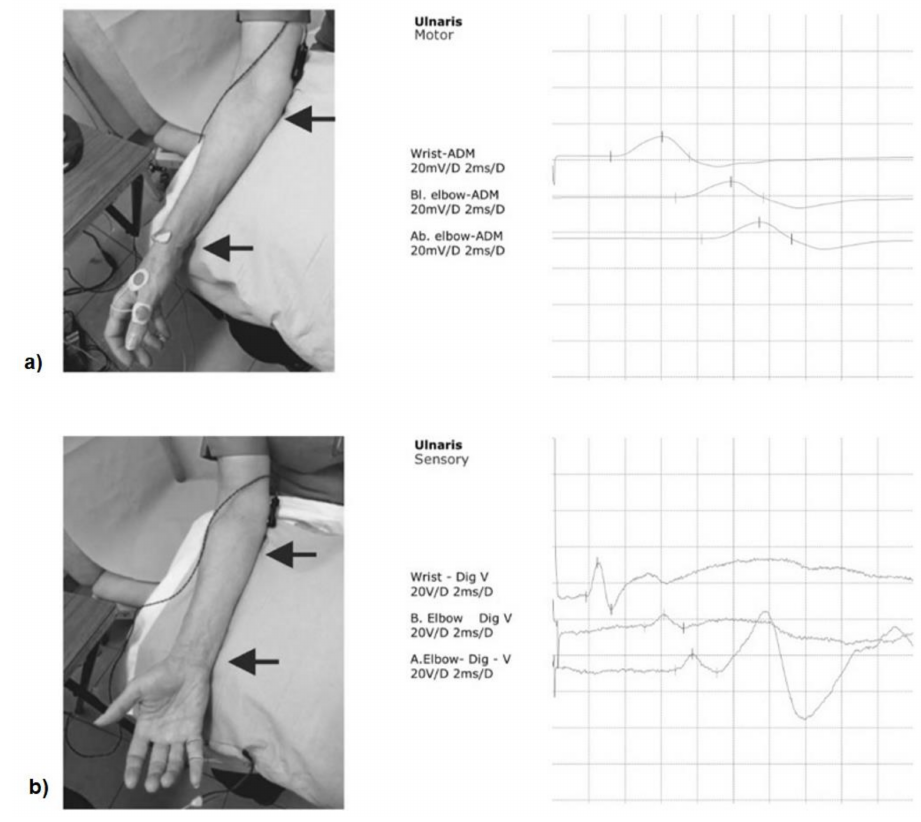
Figure 1. Ulnar nerve conduction velocity: ( a ) motor; ( b ) sensory. The compound muscle action potentials (CMAPs) were recorded non-invasively from the right FDI muscle with disposable surface electrodes placed over the muscle belly and with the reference electrode placed over the metacarpophalangeal joint of the thumb [24], and the ground electrode placed on the dorsal surface of the hand. The ulnar motor nerve conduction velocity was calculated between the wrist and just below the elbow and across the elbow. In addition, antidromic sensory nerve action potentials (SAP) were recorded using ring electrodes placed over the 5th digit, with the active and reference electrodes placed 4 cm apart. The ulnar sensory nerve conduction velocity was calculated